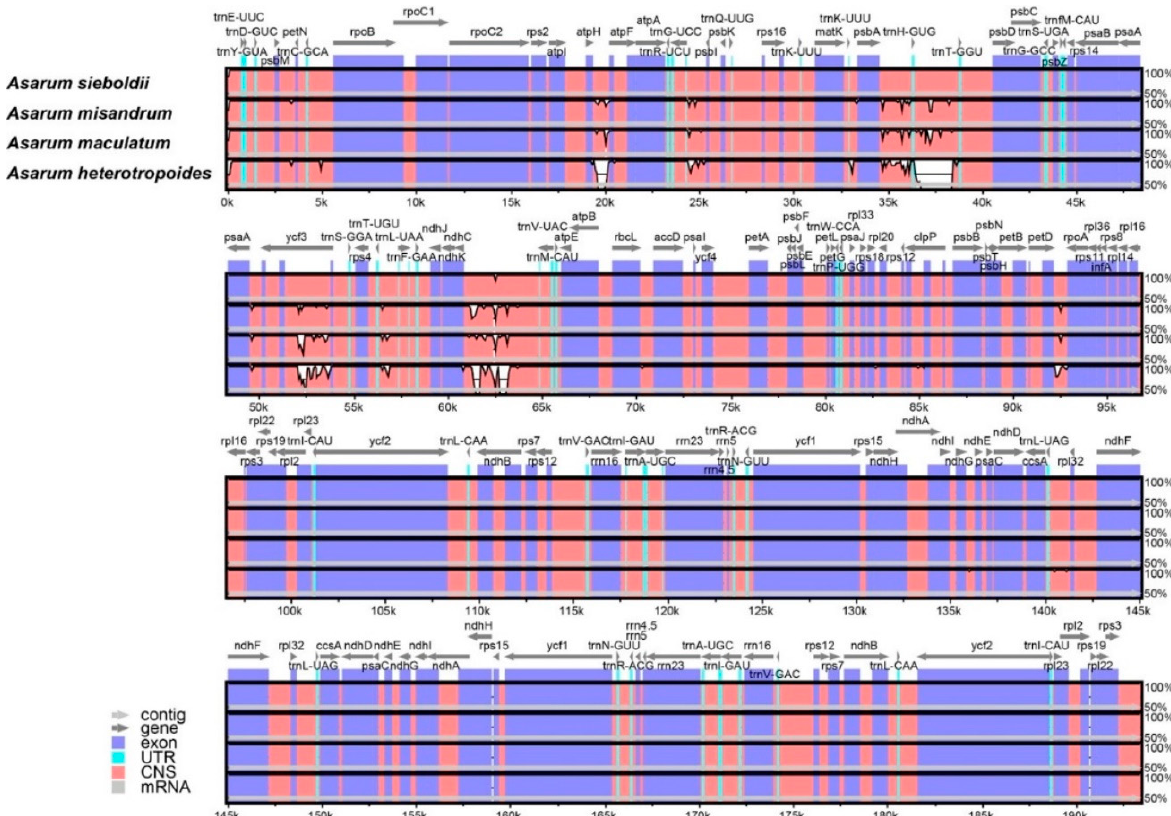
Figure 3. Comparison of the plastome structure of Asarum species using the mVISTA program. Sequence regions are colored according to their types. Transcriptional direction of the gene is represented by the direction of the arrow. The percentage on the right side indicates sequence identity among plastomes (50% to 100%). The number under the slot indicates the position in the genome. CNS = non-coding sequences, UTR = untranslated region.